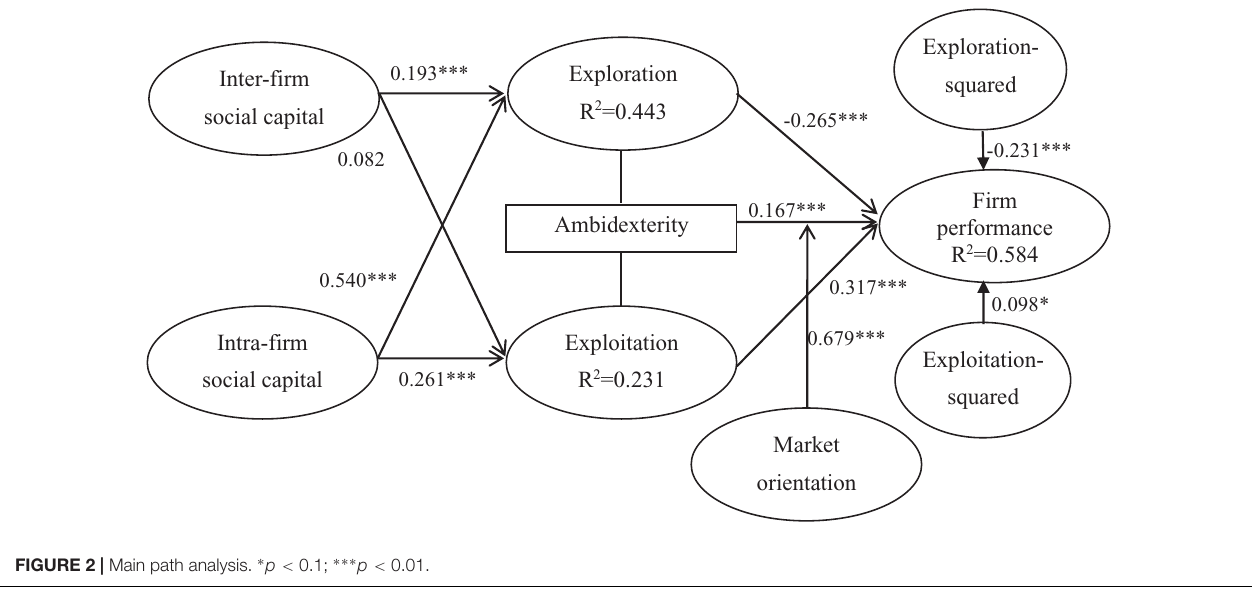
TABLE 3 | Results of the